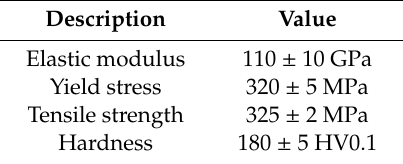
Table 2. Mechanical properties of the investigated grain-oriented electrical